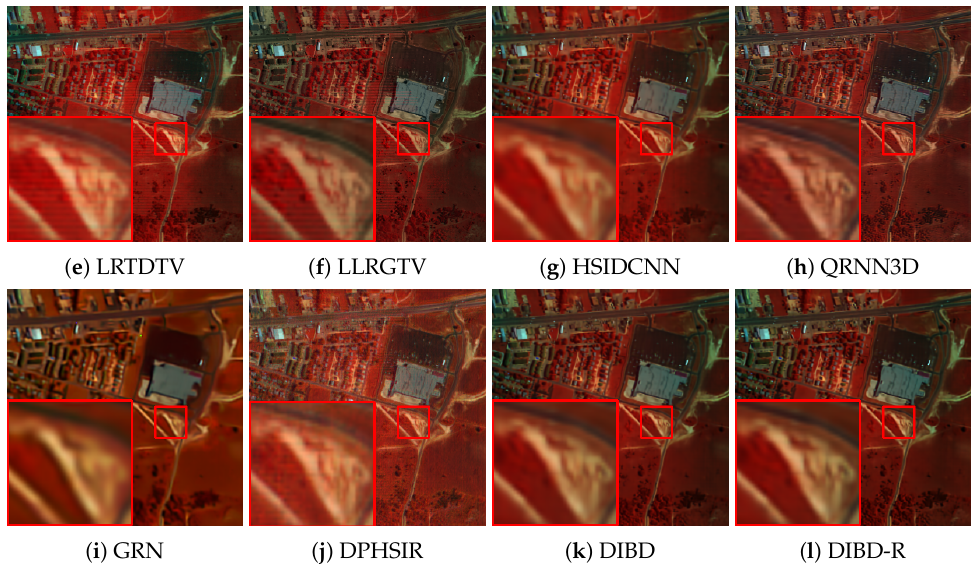
Figure 10. Urban denoising results. DIBD-R denotes DIBD training on both labeled and unlabeled mixed data . The RGB image is synthesized by HSI bands 104, 54, 24.